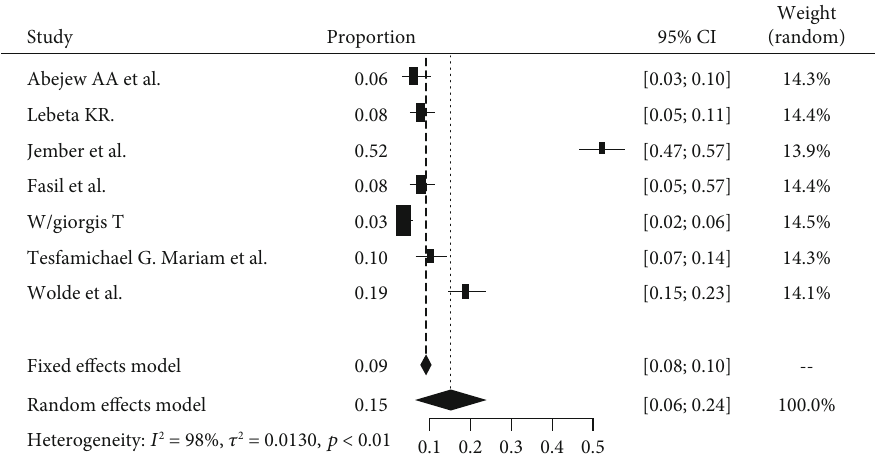
Figure 7: Forest plot of DPN in the Amhara